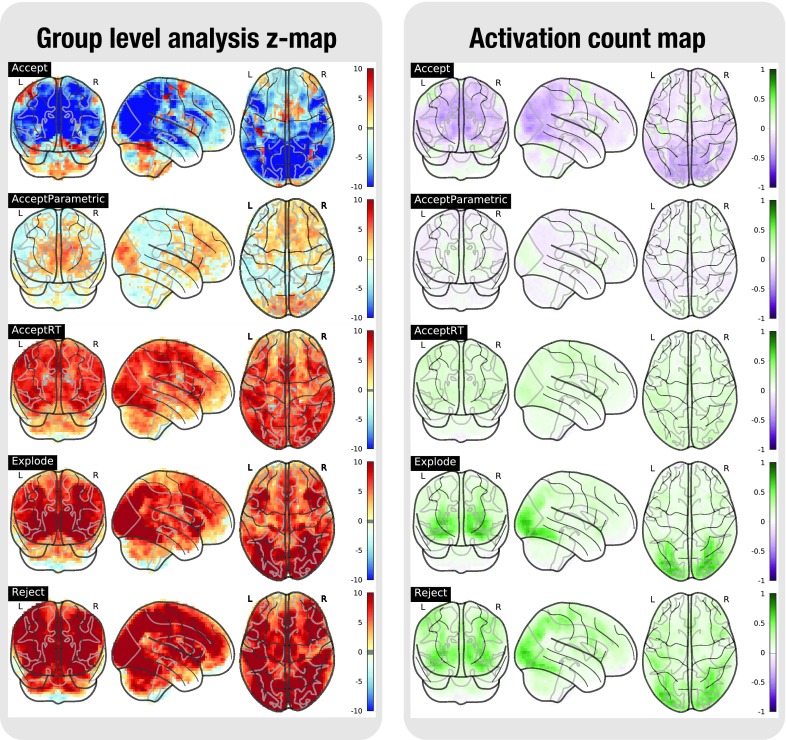
Task analysis results for the BART task.In the left plot, the statistical map of the one-sample group test, computed with randomise. The right plot shows the difference between the positive and the negative activation count maps.